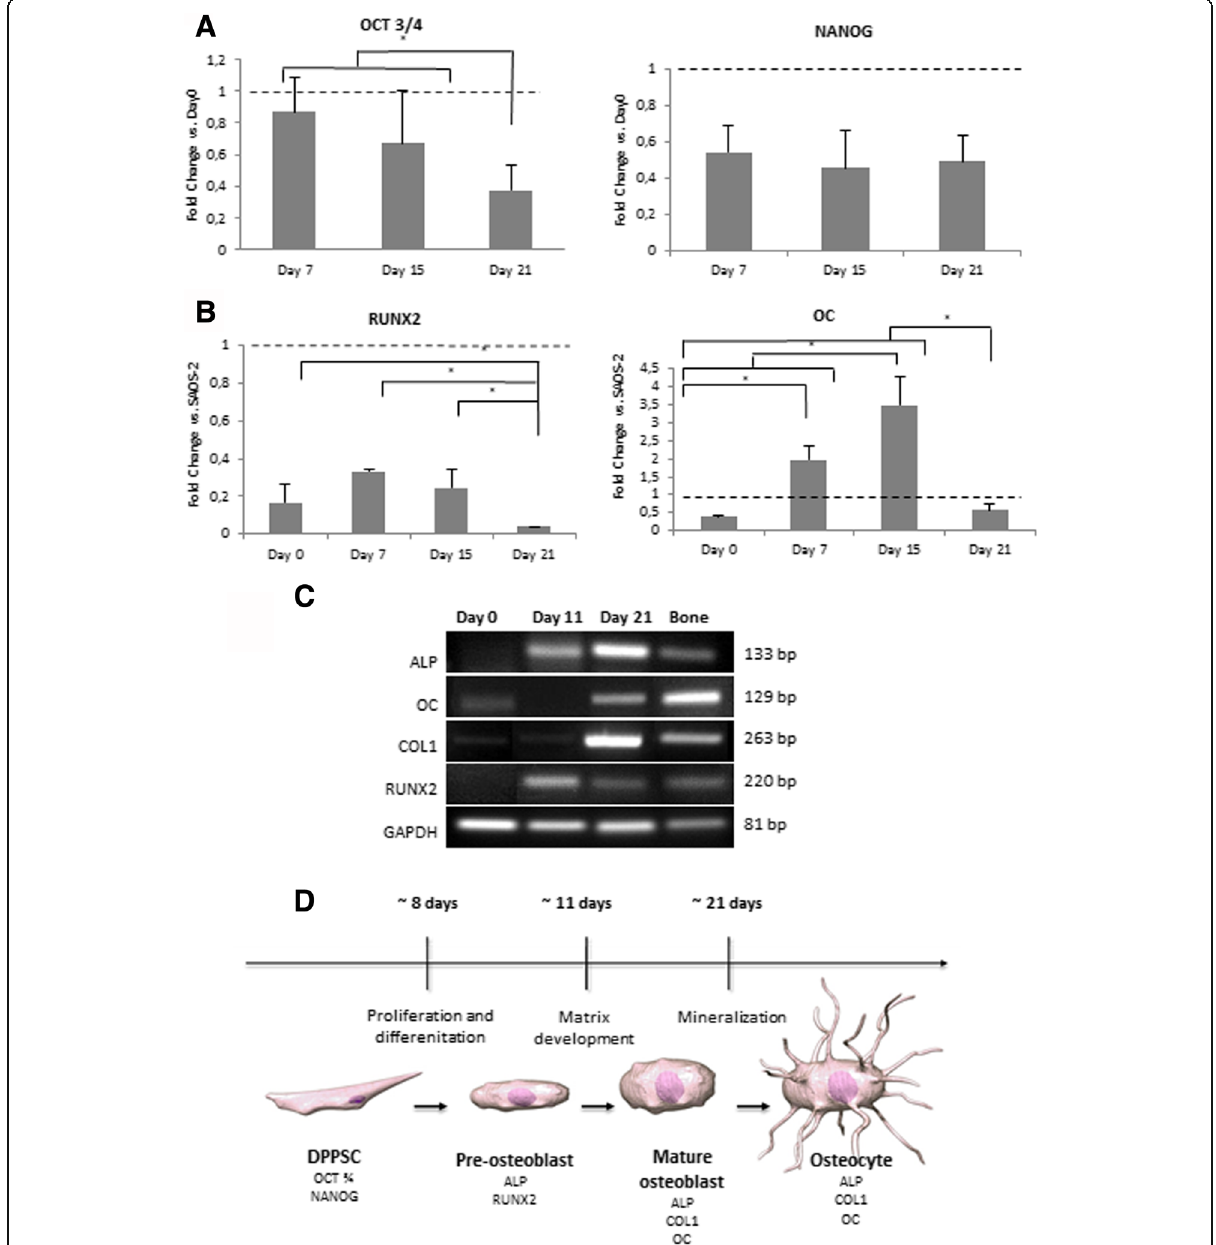
Fig. 2 Stages of DPPSC osteogenic differentiation during 21 days. a Relative expression of pluripotency (OCT3/4, NANOG) markers during the osteogenic differentiation of DPPSC versus DPPSC at Day 0 (dotted line). b Relative expression of osteogenic markers (RUNX2, OC) during the osteogenic differentiation of DPPSC versus SAOS-2 cells differentiated over 21 days in osteogenic medium ( dotted line). c RT-PCR for osteogenic markers (ALP, OC, COL1, RUNX2) at days 0, 11 and 21 of differentiation. Bone cDNA was used as a positive control and GAPDH was used as a housekeeping. d Proposed scheme for osteogenic DPPSC culture with recognizable stages of differentiation. *P <